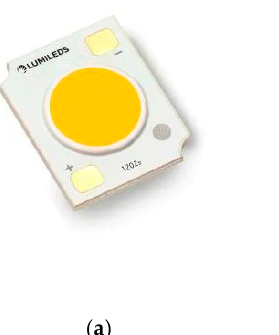
Figure 7. Test setup for phosphor sample measurements: ( a ) Schematic of the integrating sphere arrangement with excitation blue light source and passive phosphor layers attached to a temperature- controlled stage; ( b ) photograph of a custom-made phosphor sample attached to a temperature- controlled stage.